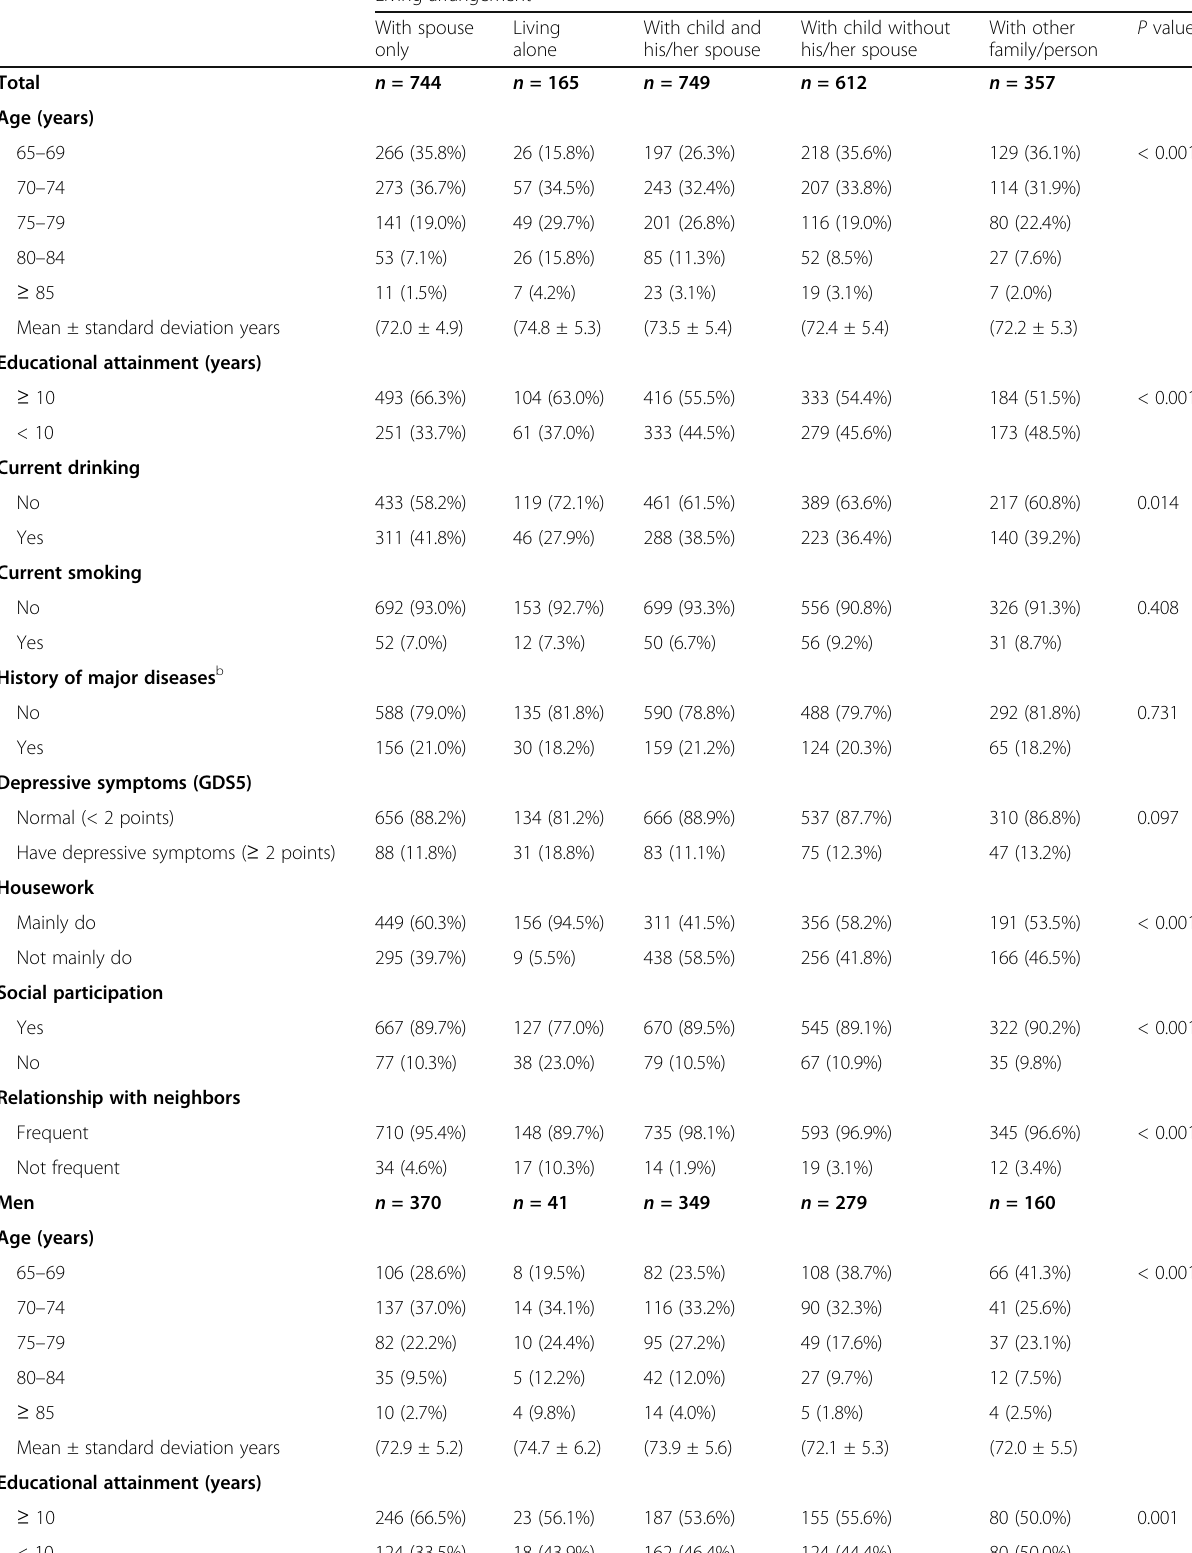
Table 1 Characteristics of the study population at baseline